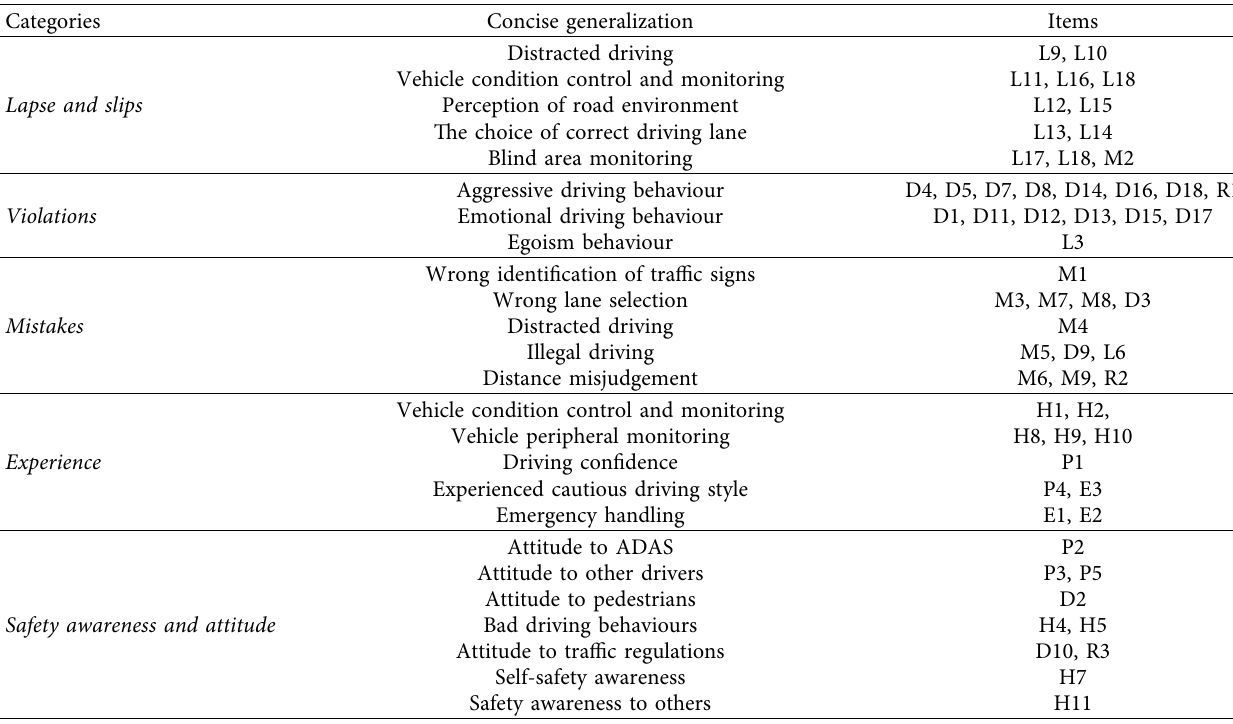
Table 6: Structure of final driving behaviour questionnaire.